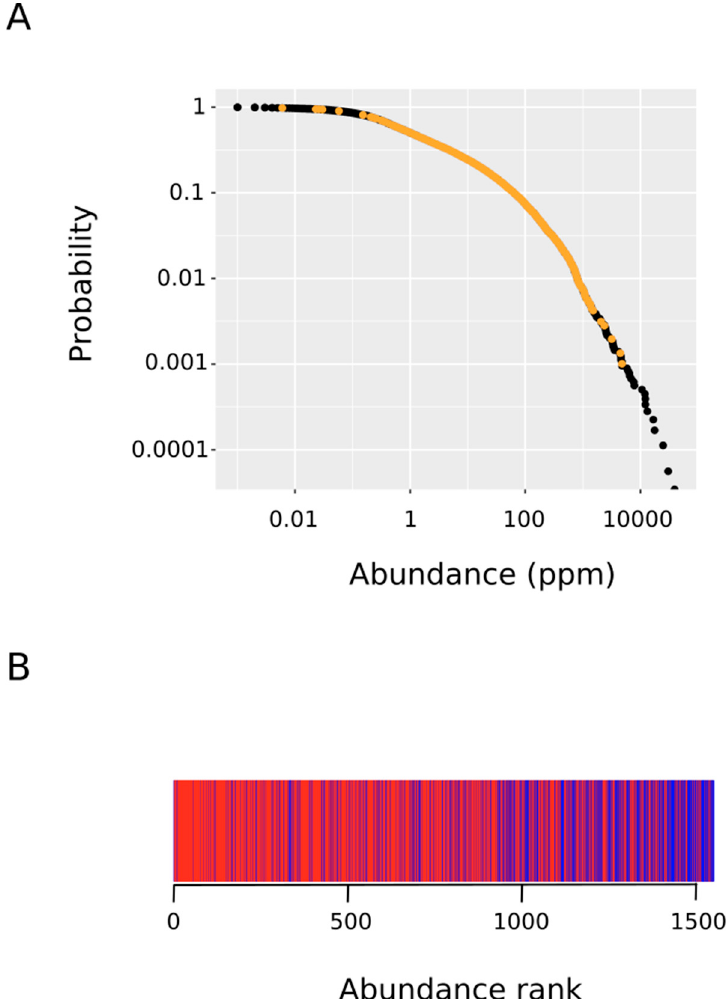
Figure 5. Rank-frequency plot of protein abundance. We started with a list of all of the human proteins along with their frequency of occurrence (abundance in parts per million). The complementary cumulative distribution P(x) of abundance x was defined as the fraction of proteins with abundance greater than or equal to x. ( A ) The plot depicts the observed complementary cumulative distribution (ordinate) versus protein abundance (abscissa). The points corresponding to MetO-containing proteins are indicated in orange. ( B ) The MetO-containing proteins were ranked in increasing order according to their abundances. Those rank positions occupied by a protein from the ex vivo set are marked in red while rank positions where a protein from the in vitro set was present are in blue.